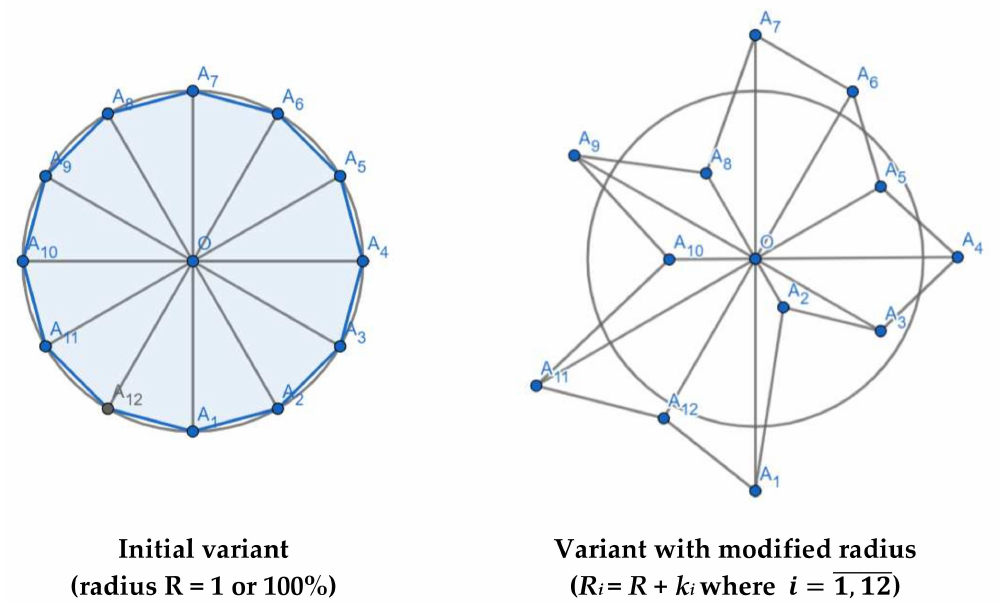
Figure 6. MID-specific graphics in “ 12-gon ” GAIN as a stellate